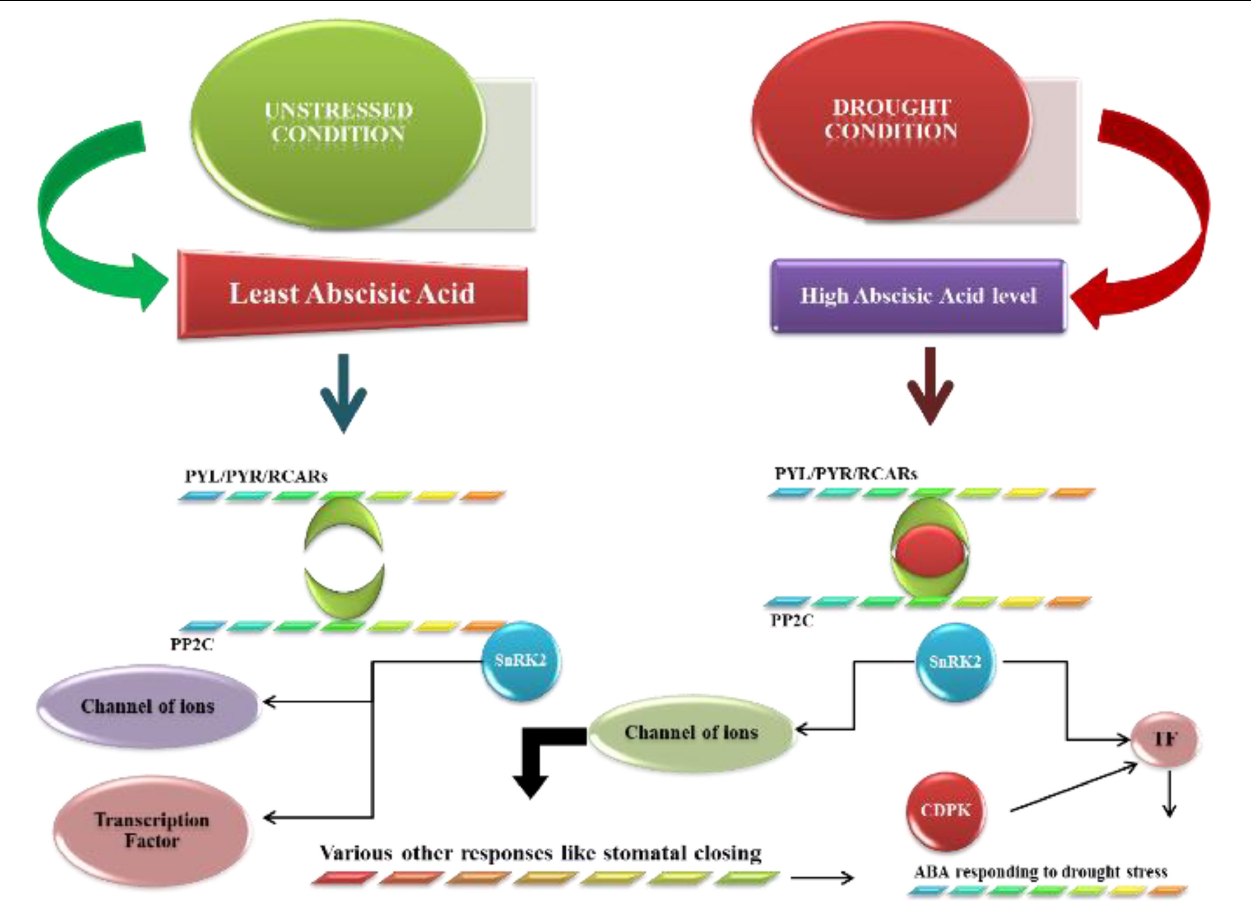
FIGURE 3 | ABA’s fundamental signaling mechanism during stressful situations. The ABA levels are lower under ideal circumstances, and the function of SnRK2 protein kinase is blocked by PP2C phosphatases. The cellular ABA level rises during high-pressure situations, and ABA then attaches to PYR/PYL/RCARs, which connect to and deactivate PP2Cs in response. If they are detached from PP2C, then SnRK2s are automatically activated. Switched on SnRK2s phosphorylate the following targets and provoke molecular and physiological reactions through ABA.